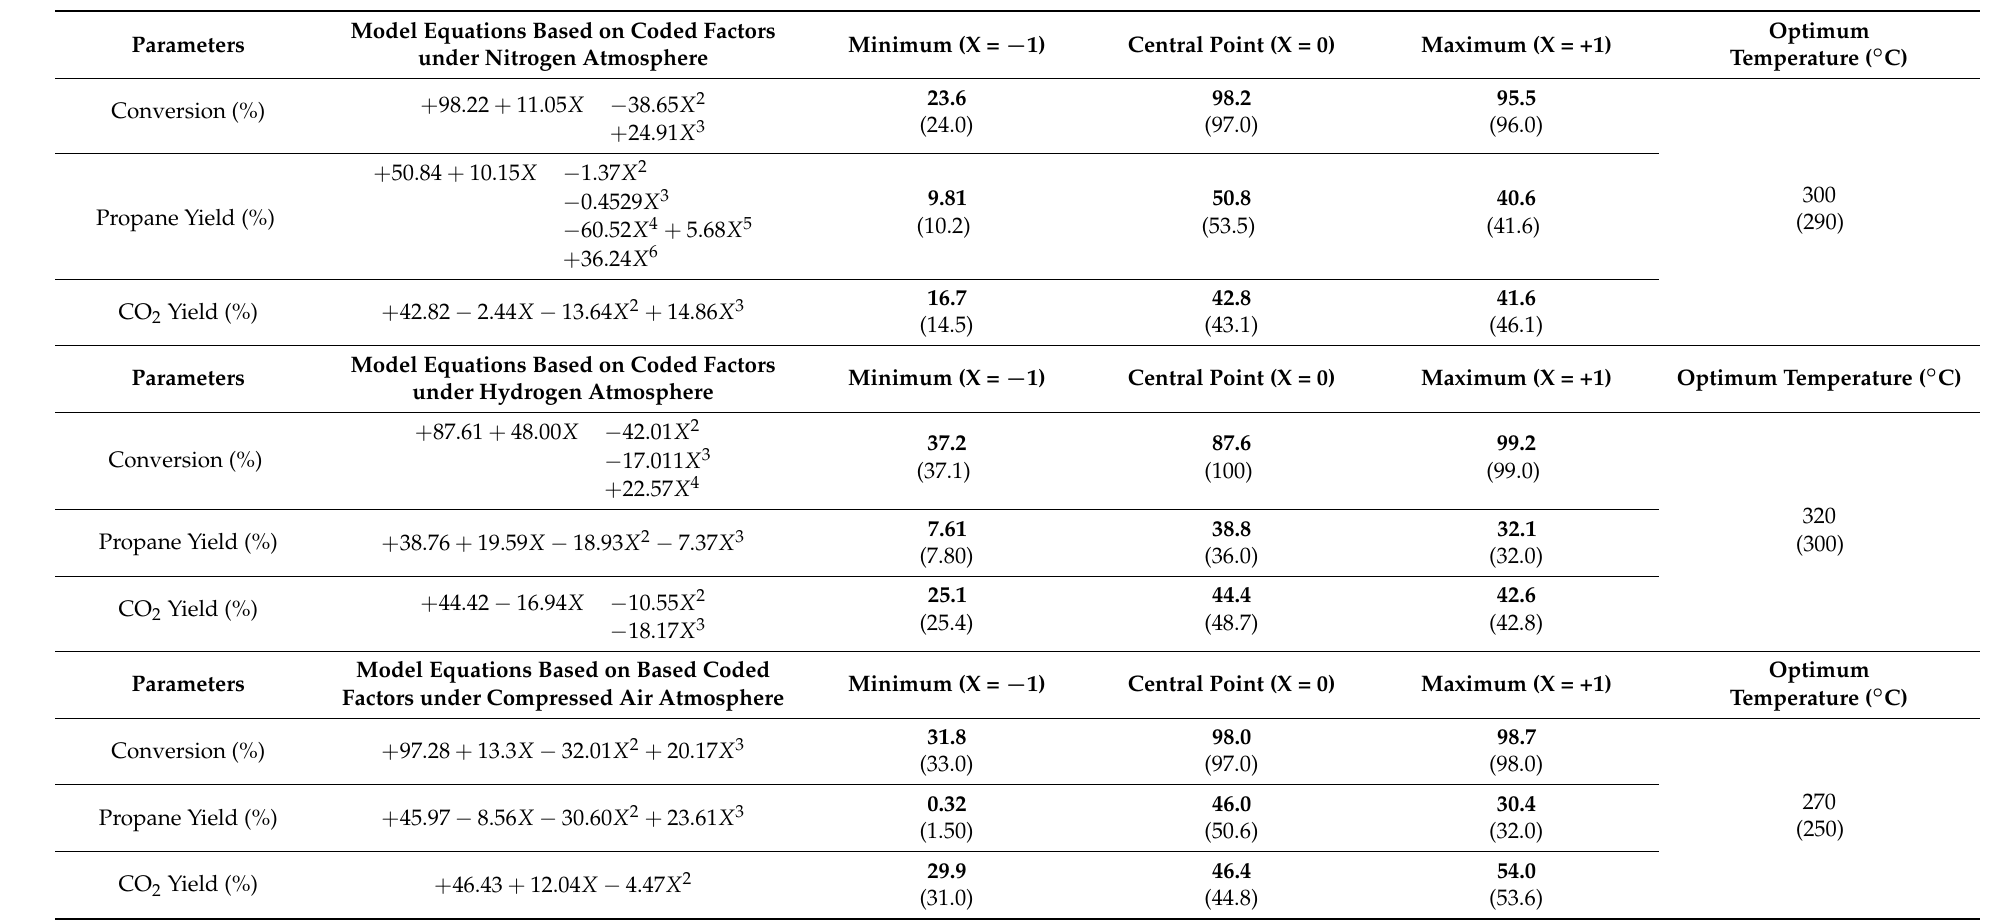
Table 5. Comparison of predicted and experimental data on butyric acid conversion and yields of propane and CO 2 using coded factors X ( − 1, 0 and +1). Experimental data in